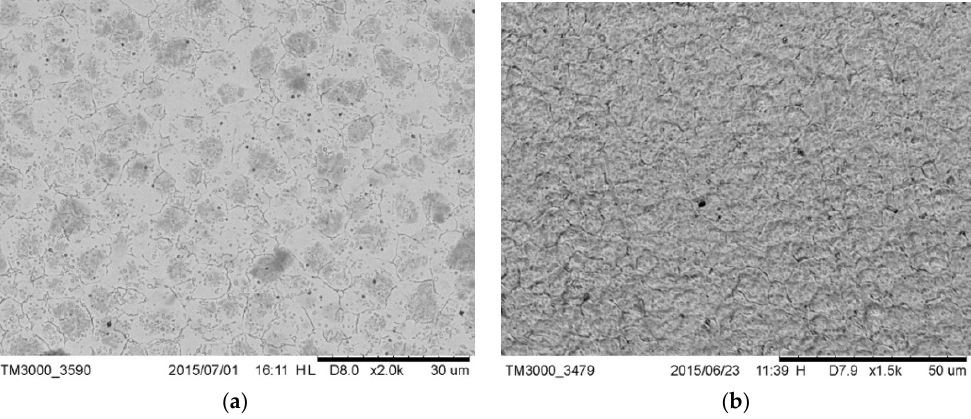
Figure 4. ( a ) Microstructure of drill A; fine dispersed carbides were visible; ( b ) external surface of drill A; the absence of mailing line was evident; it showed prominent irregular ridges.